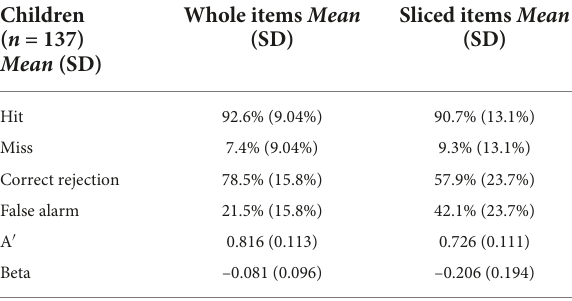
TABLE 3 Descriptive statistics for children’s categorization scores as a function of item states.